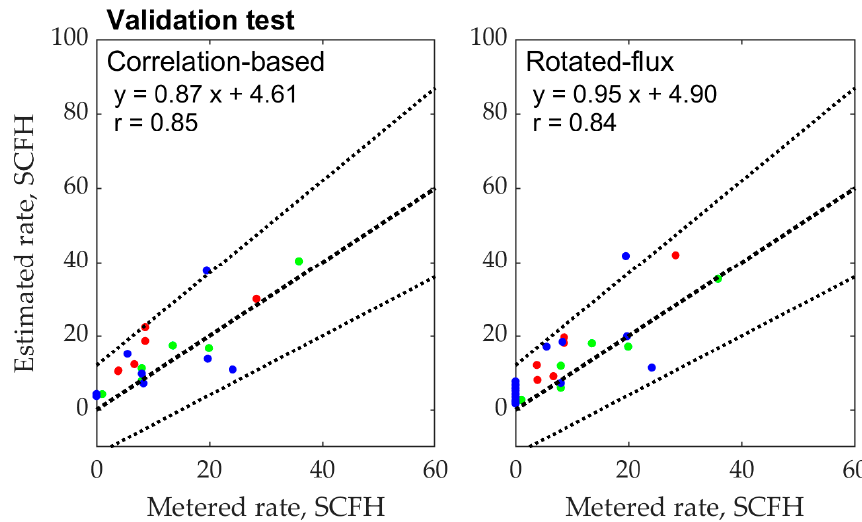
Figure 10. Quantification results during a controlled release validation experiment. The colors reflect the three different well pads (Pad 1: green, Pad 2: red, Pad 3: blue).